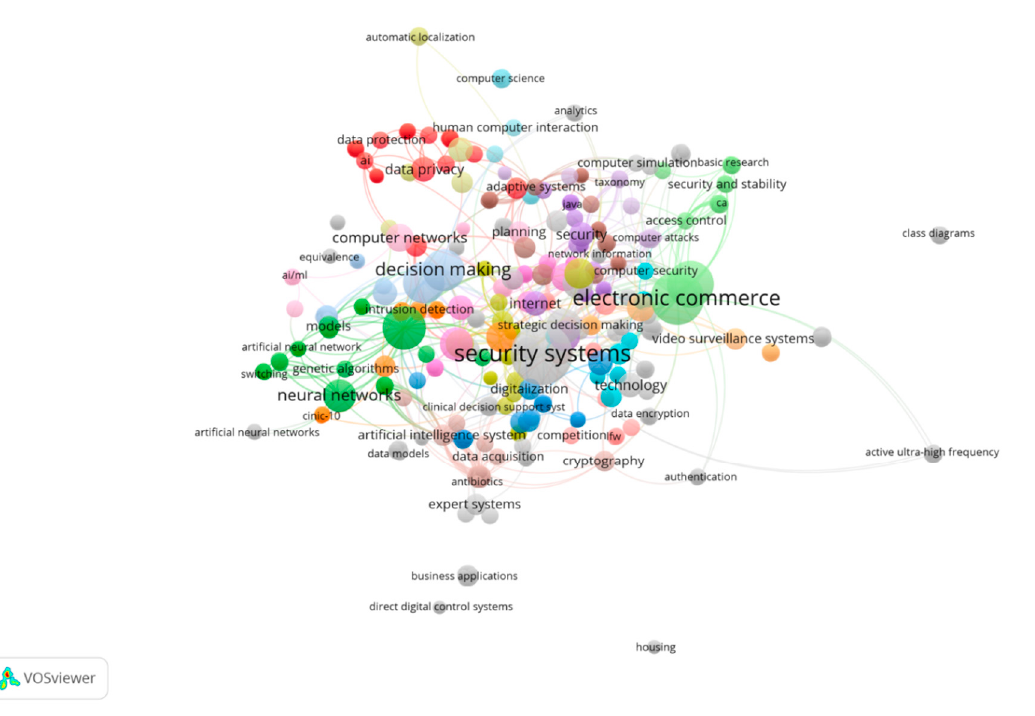
Figure 3. Evolution and number of citations between 2010 and 2021. Source: own elaboration.